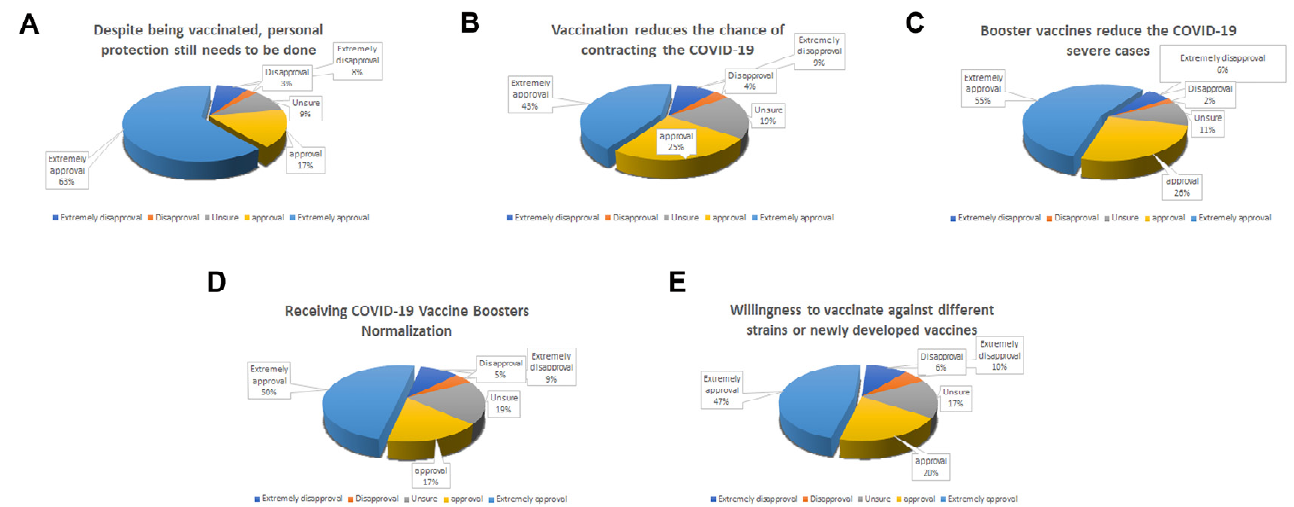
Figure 1. Public COVID-19 Vaccine Trust Survey. ( A ) Despite vaccinations, the public believes that personal protection is still needed. ( B ) Vaccination can reduce the chance of COVID-19 infection. ( C ) Booster vaccines reduce the number of severe COVID-19 cases. ( D ) Vaccination reduces the chance of contracting COVID-19. ( E ) Public willingness to vaccinate against different strains or newly developed vaccines. Percentages for ( A – E ) have been estimated using rounding, but detailed figures are mentioned in the